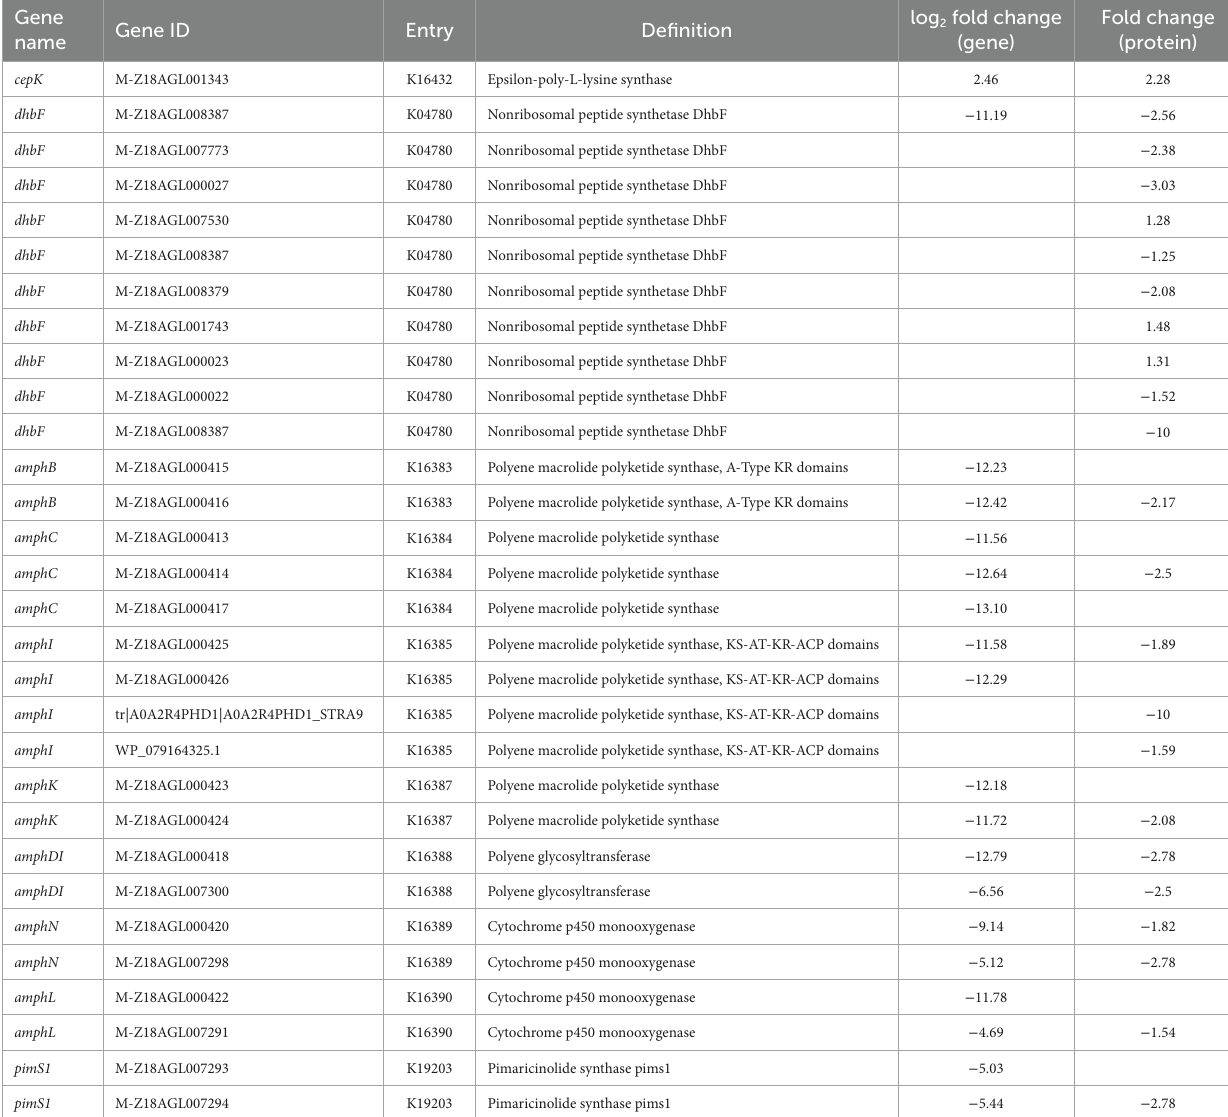
TABLE 3 Differential expression genes and proteins related to secondary